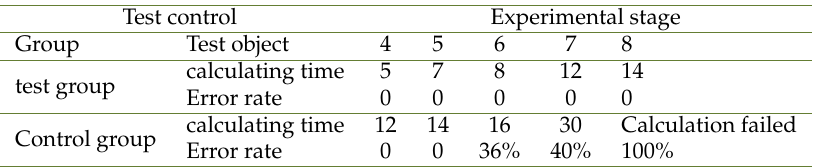
Table 2. Correctness test of algorithm